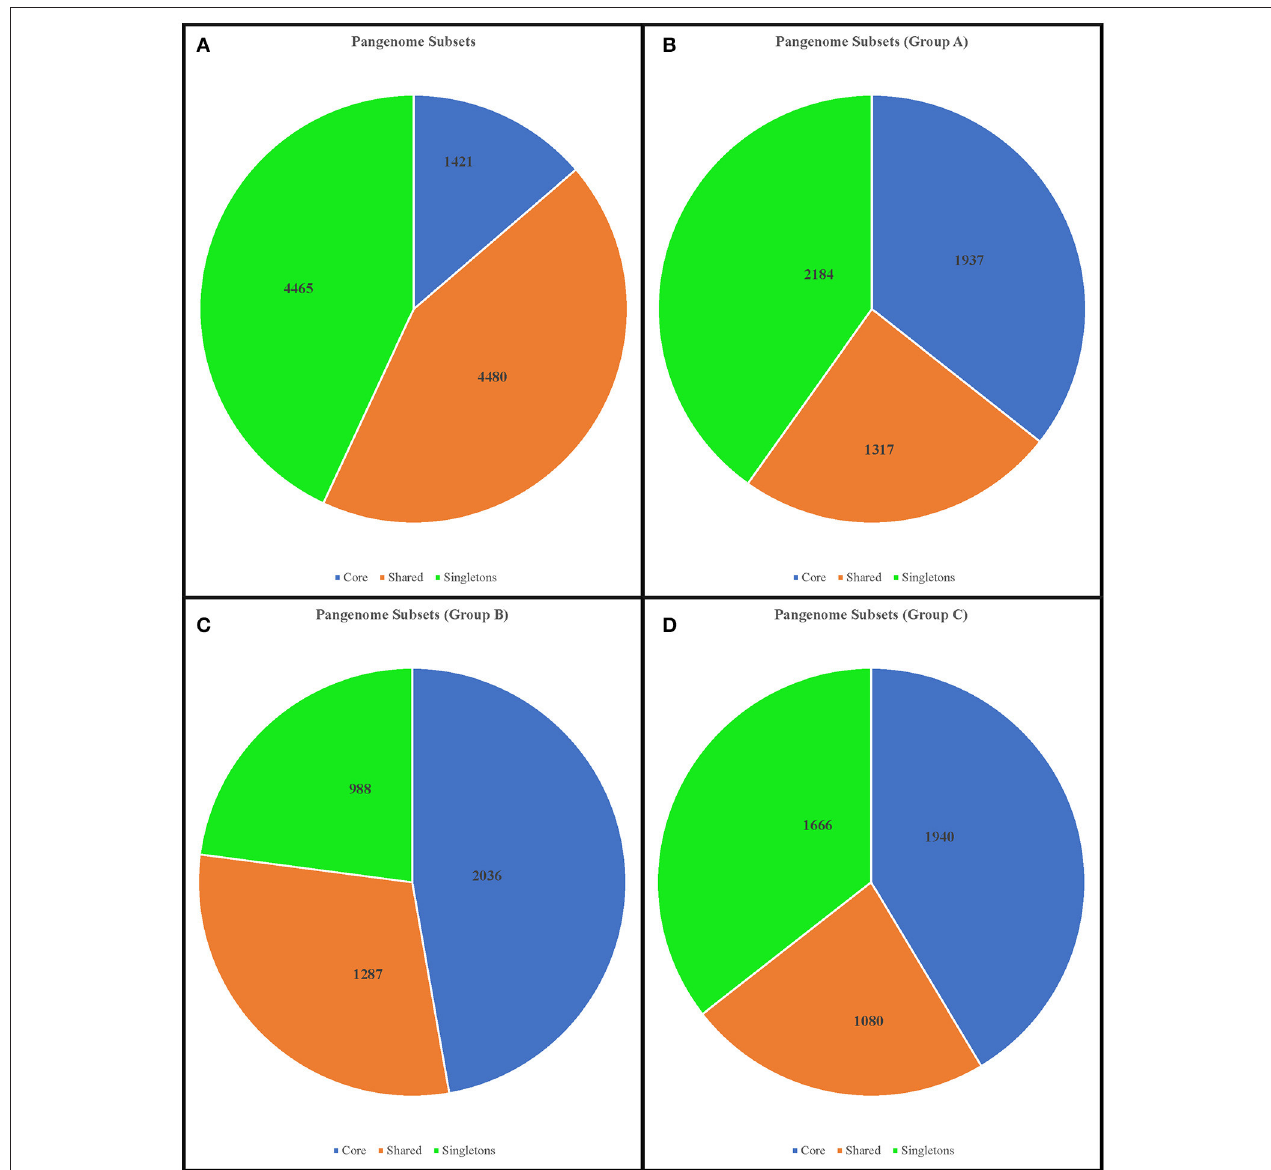
FIGURE 5 | Diagram depicting the subsets of the Faecalibacterium pangenome. The numbers represent the coding sequences belonging to each subset. Upper left chart (A) : pangenome subsets from an analysis based on all 17 genomes of Faecalibacterium . Upper right chart (B) : subset based on analysis of 5 genomes from group A. Lower left chart (C) : subset based on analysis of 4 genomes from group B. Lower right chart (D) : subset based on analysis of 4 genomes from group